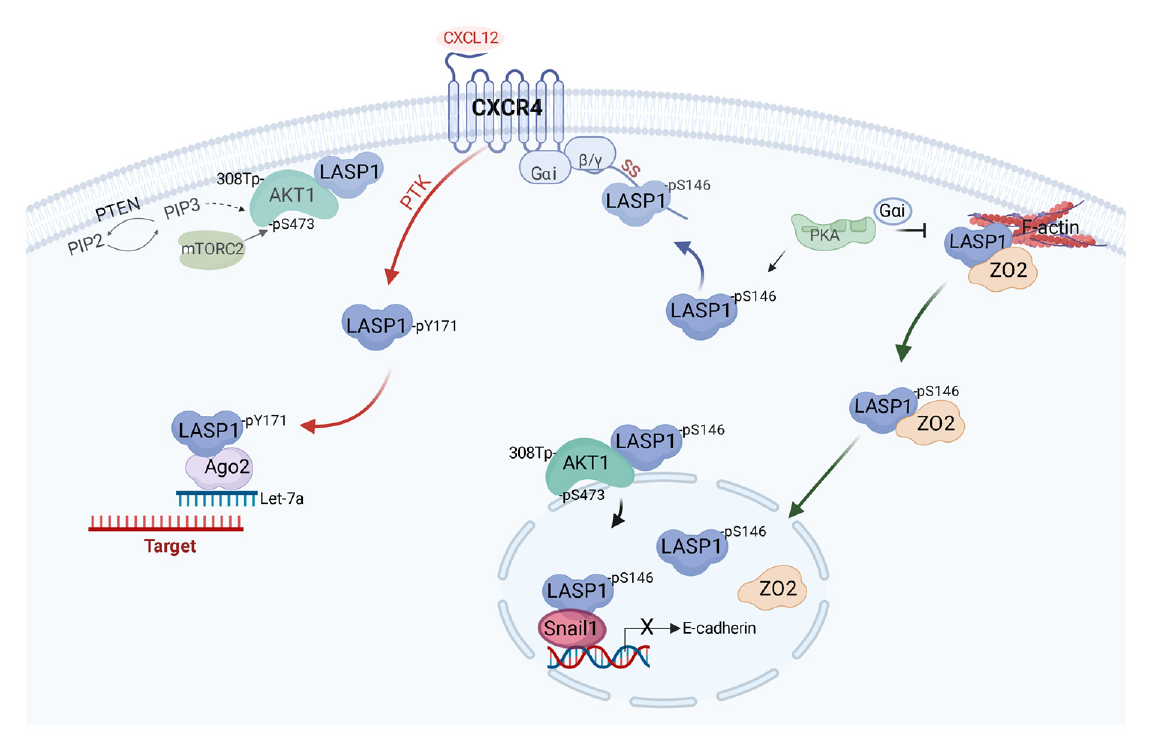
Figure 3. Phosphorylation-dependent regulation of LASP1 in TNBC. Function of LASP1 in TNBC cells is primarily regulated by its phosphorylation status at two specific sites, serine 146 (pS146) and tyrosine 171 (pY171). Unphosphorylated LASP1 primarily binds to F-actin and is complexed with other proteins such as zona occludens protein 2 (ZO2). Activation of protein kinase A (PKA) by either growth receptor signaling or G α s pathways lead to phosphorylation of LASP1 at S146. pS146- LASP1 then preferentially binds to the C-terminal tail of chemokine receptor CXCR4 (implicated in breast cancer metastasis). Concurrently, pS146-LASP1 anchors AKT1 to the cell membrane serving as a scaffold and a facilitator of signaling between PTEN and mTORC2. Some pS146-LASP1 also dissociates from F-actin and is transported to the nucleus in a ZO2-dependent mechanism. Within the nucleus, pS146-LASP1 associates with proteins such as Snail1 which increases the stability of this transcriptional factor and promotes epithelial-to-mesenchymal transition through repression of epithelial markers such as E-cadherin. Once CXCR4 is activated, a fraction of LASP1 is preferentially phosphorylated at Y171 by phosphotyrosine kinases (PTK), inhibiting its interaction with the CXCR4 C-terminal tail. Concomitantly, G-protein α i is released, inhibiting PKA and potential for S146 function. pY171-LASP1 facilitates other aspects of the metastatic cascade through interactions with other proteins such as the RNA-induced-silencing-complex via binding to argonaute protein (Ago2). Pathway was created using BioRender software: https://biorender.com; accessed on 12 October 2022.